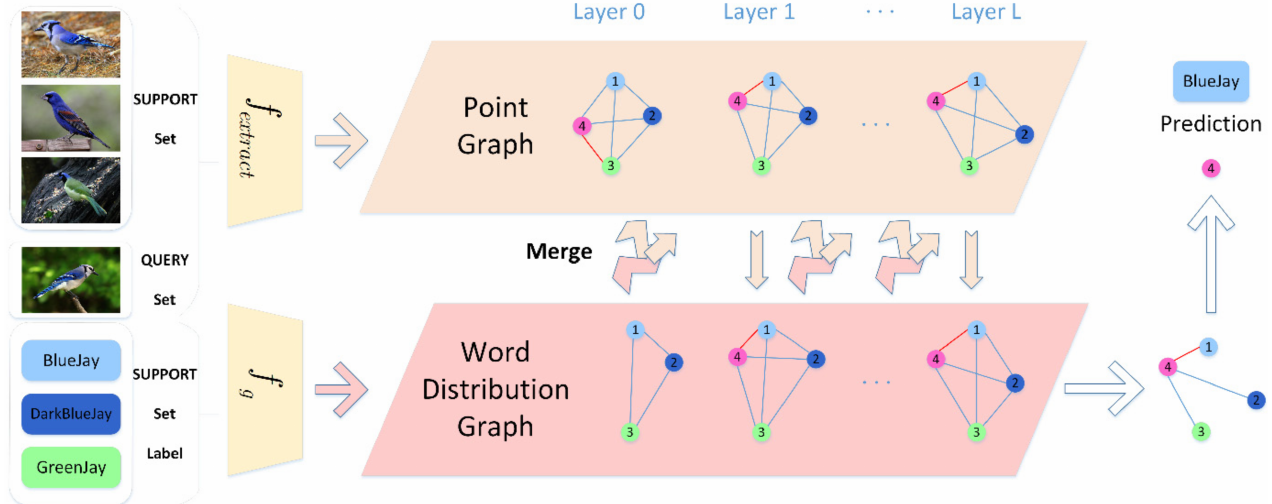
Figure 1. The figure shows a 3-way-1 shot task, where 1, 2, 3 represent the support set, 4 represents the query set, and the red line segment represents the mini-mum similarity between 4 and other support set samples. After cyclic calculation of the L-layer Point Graph and Word Distribution Graph, the class output with the closest distance between 4 and the other three types of samples in the Word Distribution Graph is finally selected as the prediction